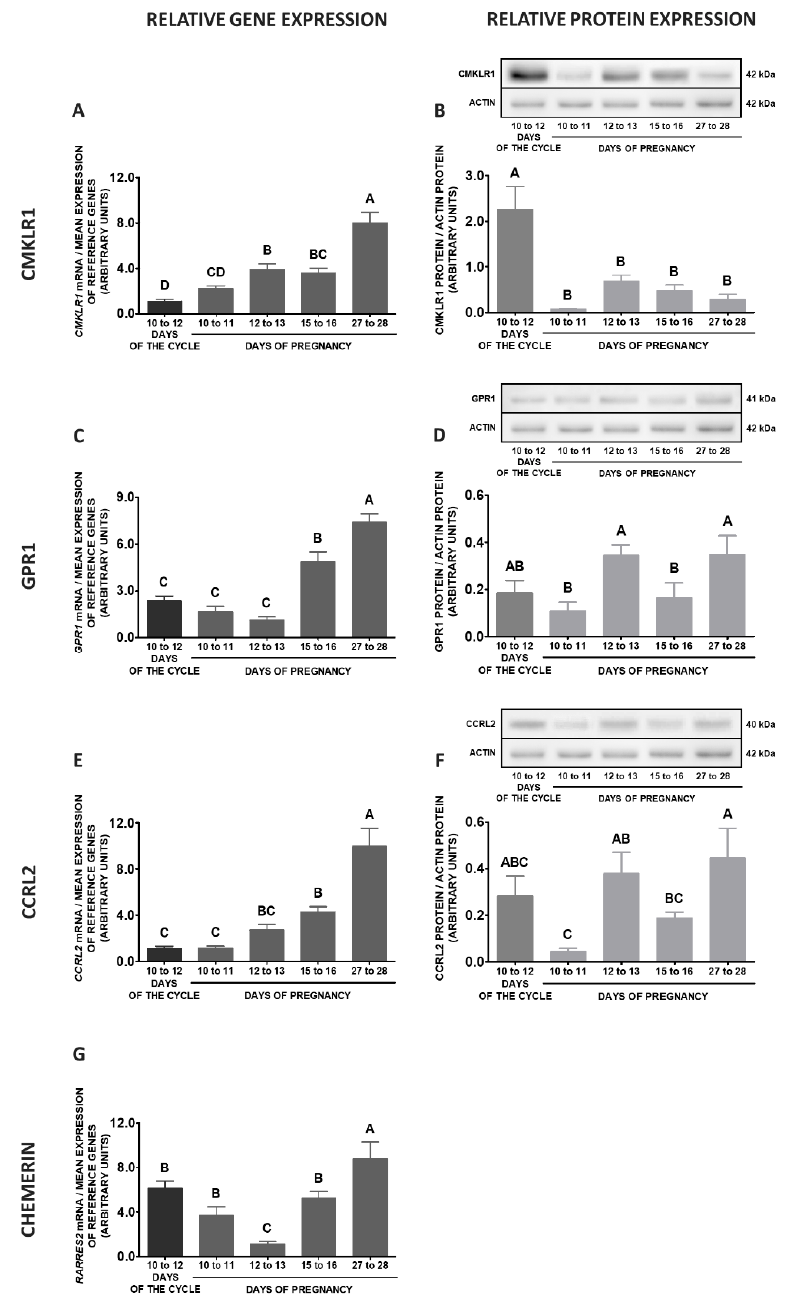
Figure 13. Chemerin system expression in the porcine stalk median eminence (SME)—pregnancy vs. oestrous cycle. Gene and protein expression of chemokine-like receptor 1 (CMKLR1; A and B ), G protein-coupled receptor 1 (GPR1; C and D ) and C-C motif chemokine receptor-like 2 (CCRL2; E and F ), as well as chemerin ( RARRES2 ) mRNA content ( G ) in the porcine SME on days: 10 to 11, 12 to 13, 15 to 16 and 27 to 28 of pregnancy, and on days 10 to 12 of the oestrous cycle. Gene expression was determined by qPCR. Protein expression was determined by Western blotting; upper panels: representative immunoblots; lower panels: densitometric analysis of CMKLR1/GPR1/CCRL2 proteins relative to actin protein. Representative actin blots are identical for all chemerin receptors though proteins have been analysed on different gels. Results are presented as means ± SEM ( n = 5). Bars with different superscripts differ (one-way ANOVA at p < 0.05 followed by Tuckey post-hoc test at p < 0.05).